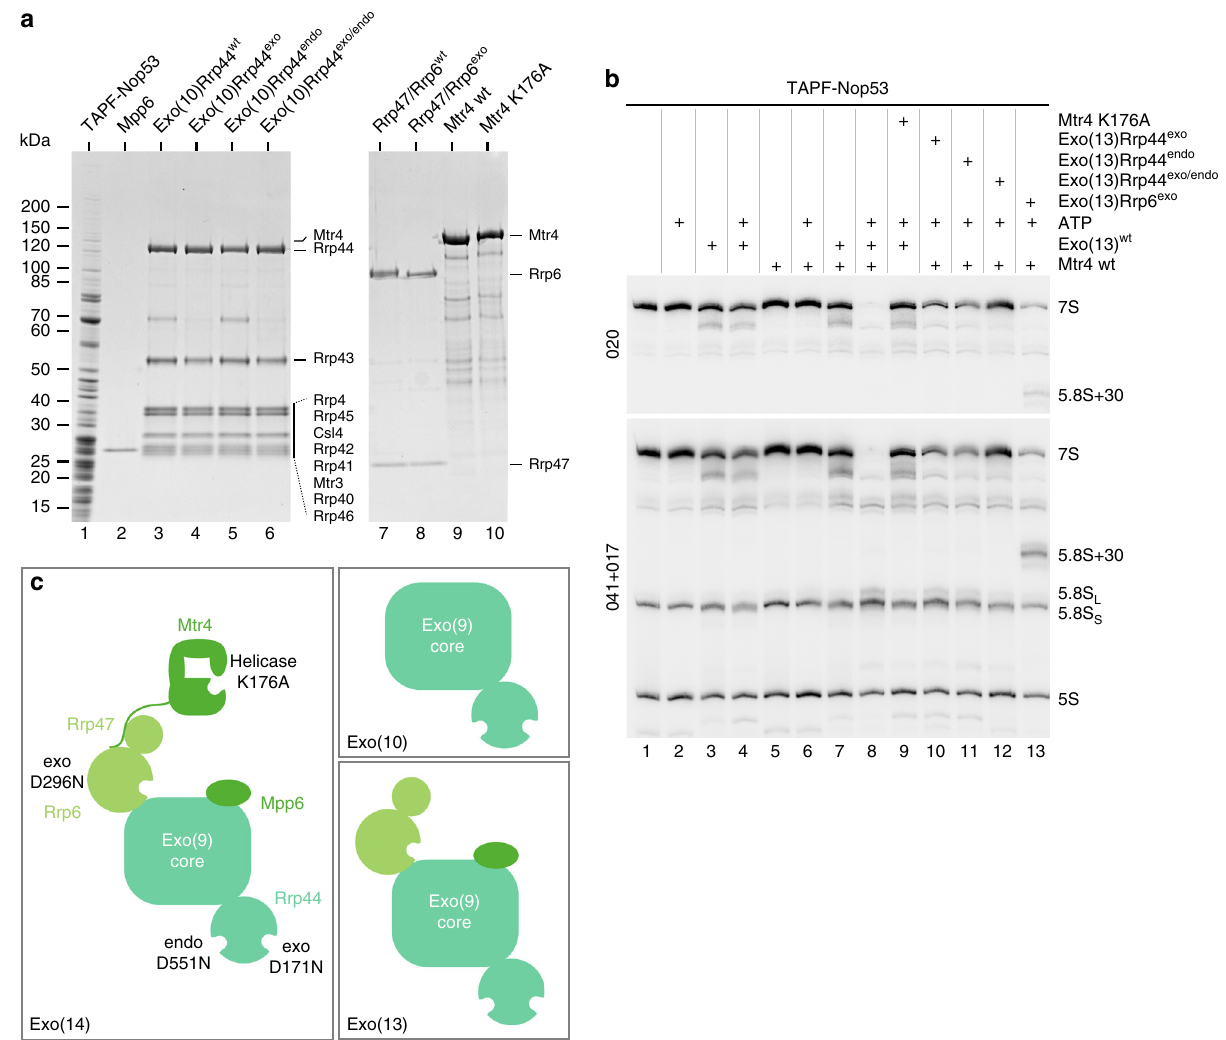
Fig. 2 In vitro assay for 7S → 5.8S pre-rRNA processing in puri fi ed pre-60S particles catalysed by the recombinant nuclear exosome and cofactors. a SDS- PAGE and Coomassie staining of the protein samples used for in vitro 7S → 5.8S pre-rRNA processing. Pre-60S particles containing 7S substrate pre-rRNA were af fi nity-puri fi ed via TAPF-Nop53. All the yeast exosome subunits and Mtr4 were expressed recombinantly in E. coli and subsequently puri fi ed from cell lysates. Exo(10) comprises the exosome core and includes Rrp44, either in wt or catalytic mutant form, Exo(10)Rrp44 exo , Exo(10)Rrp44 endo , Exo(10) Rrp44 exo/endo , Rrp47 and Rrp6, in mutant and wt form, the latter added as a dimer, and Mpp6 alone. Together, they form Exo(13), which corresponds to the endogenous exosome puri fi ed via Rrp6-FTpA. b Northern blot for the detection of 7S pre-rRNA, 5.8S rRNA and 5S rRNA species after the in vitro processing reaction. Processing of 7S pre-rRNA from pre-60S particles (TAPF-Nop53) using the recombinantly puri fi ed exosome (Exo(13)) in wt and mutant forms and its cofactor Mtr4, either wt or K176A mutant, in the presence or absence of ATP. 7S pre-rRNA was detected with two different probes. 5S rRNA served as a loading control. c Schematic representation of the different exosome modules/complexes — Exo(10), Exo(13) and Exo(14) — assembled using recombinant proteins, used in the various in vitro processing assays. Exo(14) also contains the Mtr4 helicase. Further depicted are the enzymatically active subunits of the exosome with their catalytic centres (exonuclease, endonuclease, ATPase) and the mutations generated at these sites